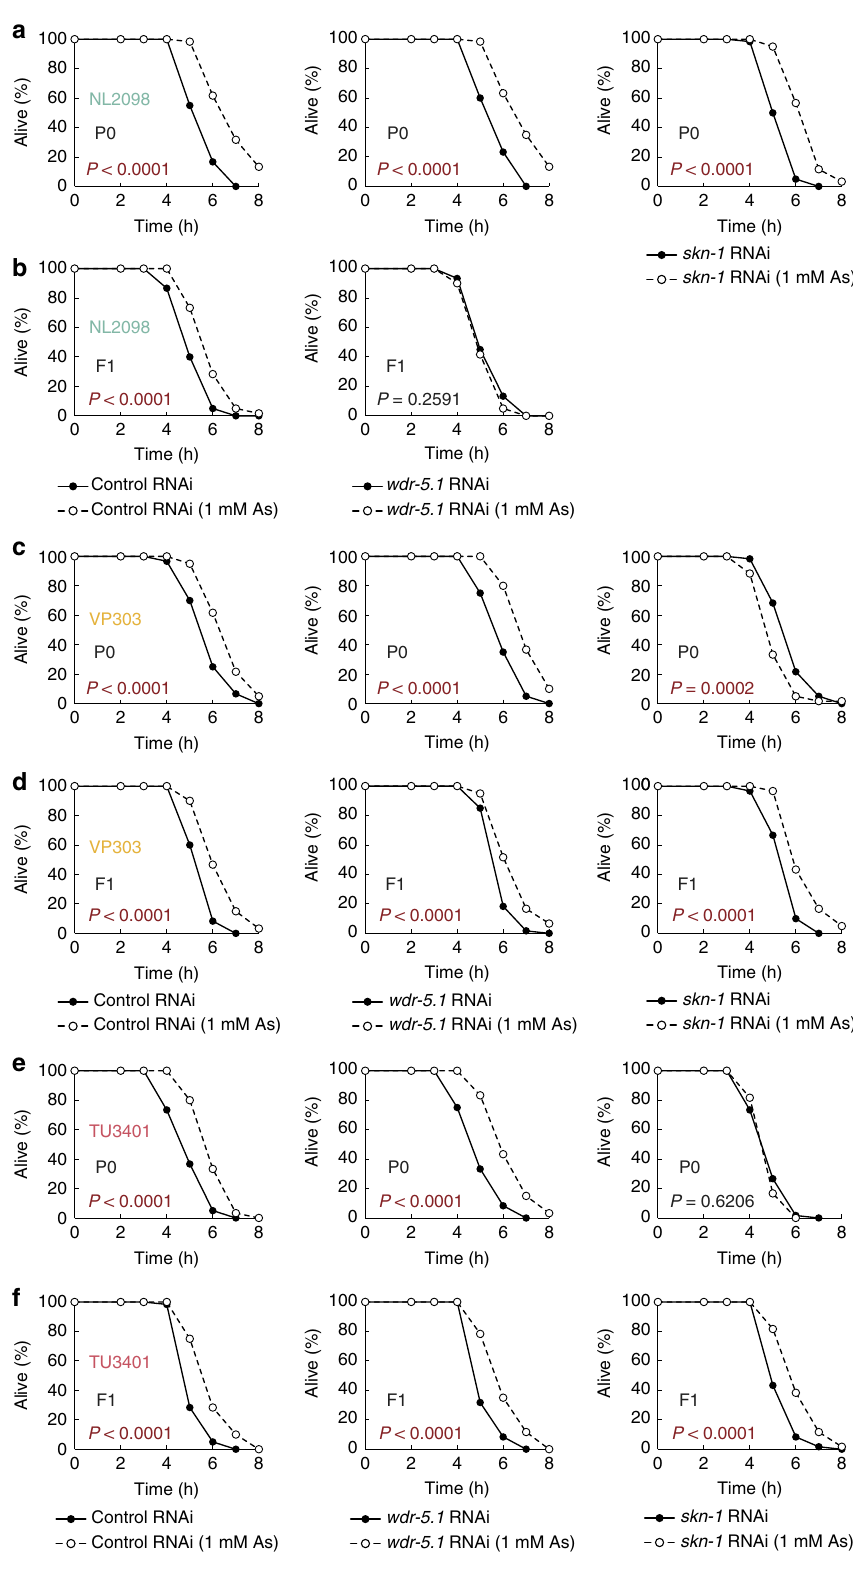
Figure 6 | Tissue-specific RNAi of wdr-5.1 or skn-1 . ( a , b ) Oxidative stress resistance (2mM H 2 O 2 ) of the stressed P0 parents treated with germline- specific RNAi (left, empty vector (control); middle, wdr-5.1 ; right, skn-1 ) on day 2 adulthood ( a ) and the self-fertilized F1 descendants on day 1 adulthood ( b ). ( c , d ) Oxidative stress resistance (2mM H 2 O 2 ) of the stressed P0 parents treated with intestine-specific RNAi on day 2 adulthood ( c ) and the self-fertilized F1 descendants on day 1 adulthood ( d ). ( e , f ) Oxidative stress resistance (2mM H 2 O 2 ) of the stressed P0 parents treated with neuron-specific RNAi on day 2 adulthood ( e ) and the self-fertilized F1 descendants on day 1 adulthood ( f ). Two independent experiments are integrated into each survival curve ( n ¼ 60). P values were calculated by log-rank